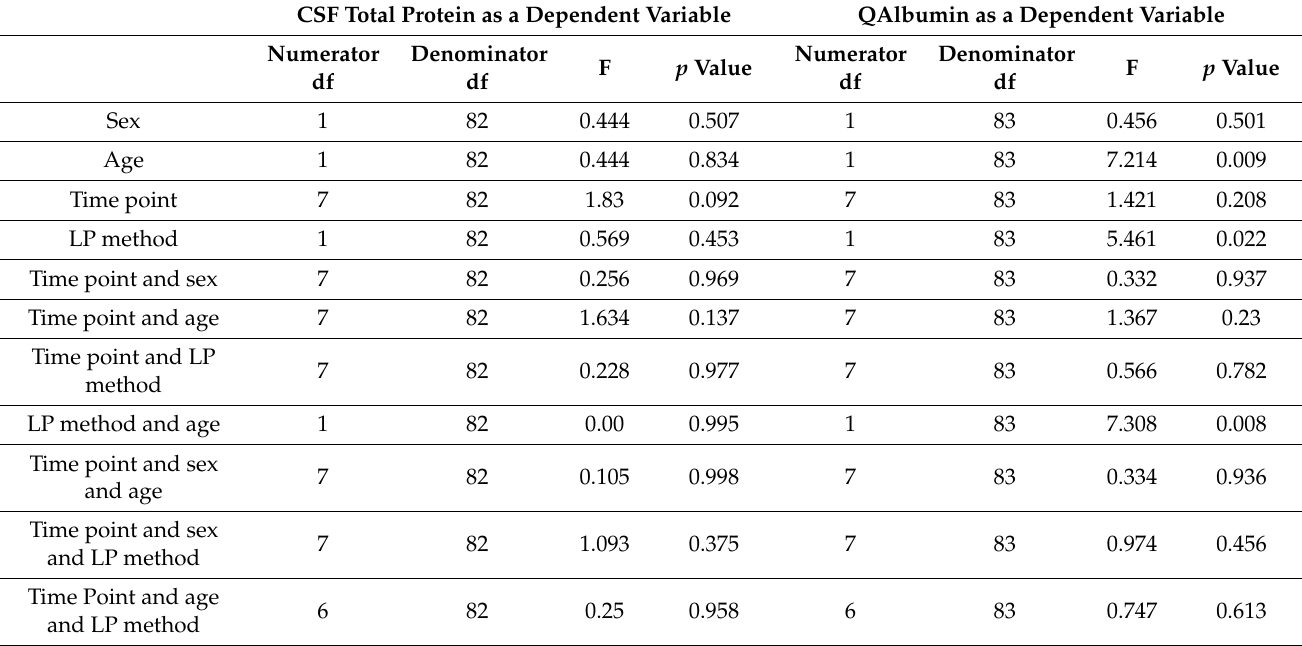
Table 4. Predictors of CSF total protein and QAlbumin values. A mixed linear model was used. Time point refers to nusinersen injection (d0, d14, d28, d63, m6, m10, m14, m18). LP method refers to CT-guided or conventional LP. CSF: cerebrospinal fluid; LP: lumbar puncture; QAlbumin: CSF/serum albumin